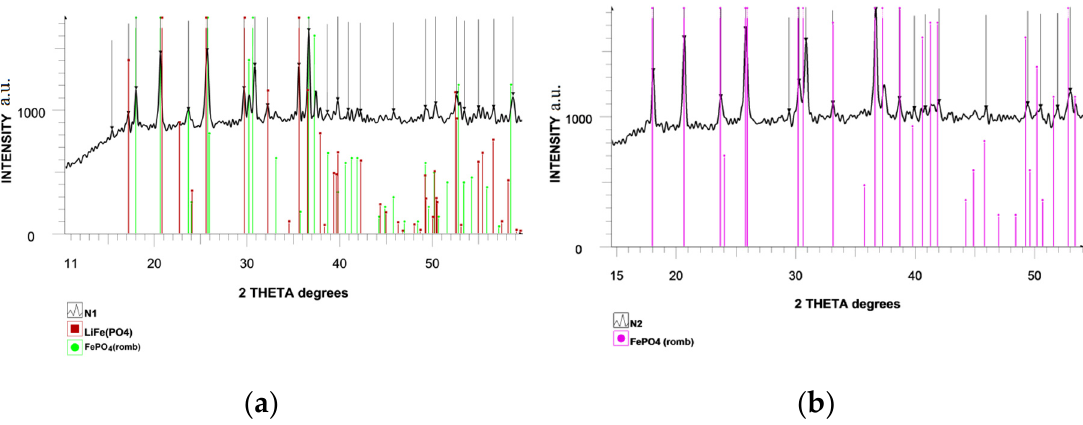
Figure 9. XRD patterns of ( a ) half ‐ oxidized and ( b ) completely oxidized LFP/C, respectively.